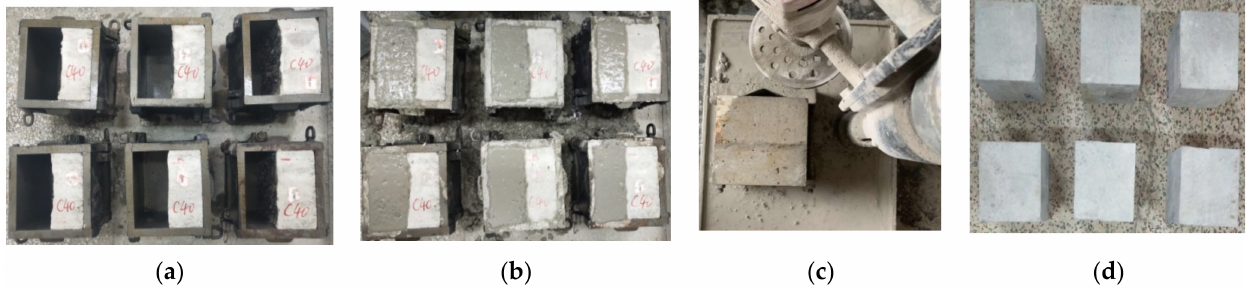
Figure 4. Main process of specimen formation: ( a ) precast concrete placed into module; ( b ) cast-in-situ concrete poured into mold; ( c ) polishing load surface; ( d ) prepared specimens in dimension of 150